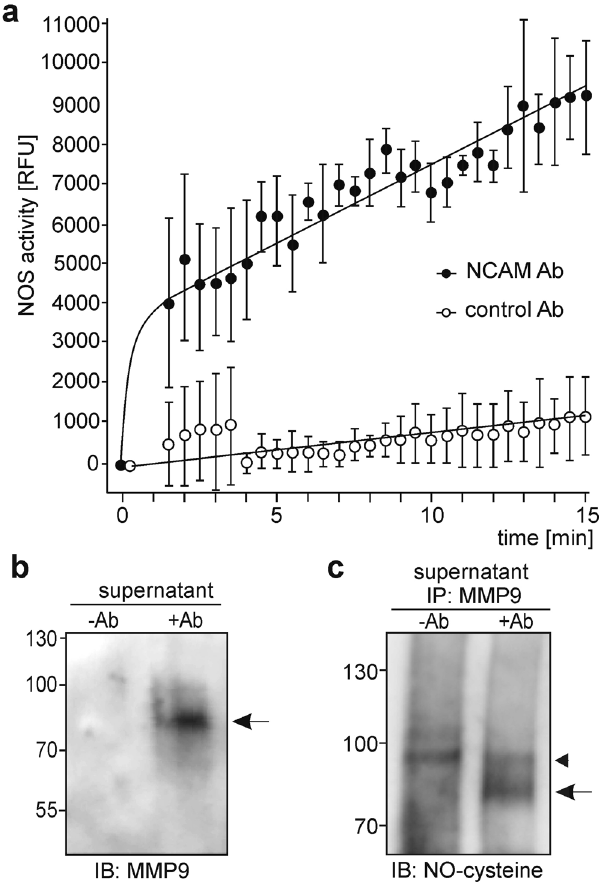
Figure 5. NCAM antibody treatment triggers NO production and S-nitrosylation of MMP9. ( a ) Cerebellar neurons were incubated with guinea pig NCAM antibody (25 µ g/ml IgG) or control antibody (25 µ g/ml IgG) and the intracellular NO levels were determined before and after antibody treatment (every 30 s for 15 min). Mean values with standard deviation from 3 independent experiments are shown for the NO levels. ( b , c ) Cerebellar neurons were incubated without ( − Ab) or with guinea pig NCAM antibody (25 µ g/ml IgG) ( + Ab) for 10 min. Cell culture supernatants were collected and subjected to modification of S-nitrosyl residues of proteins and exchange by biotin ( b ) or to immunoprecipitation with MMP9 antibody followed by immunoblot analysis of the immunoprecipitates with S-nitroso-cysteine antibody ( c ). ( b ) Biotinylated proteins were isolated and probed by immunoblot analysis with MMP9 antibodies for detection of S-nitrosylated